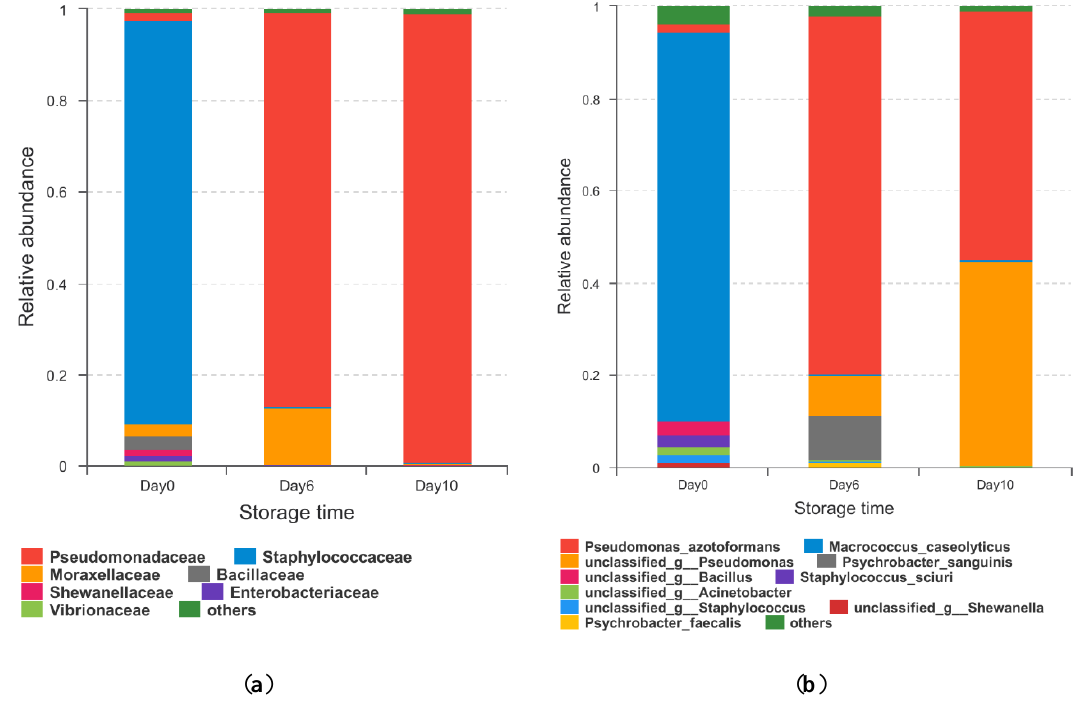
Figure 3. Community barplot analysis of microbiota at the genus level ( a ) and species level ( b ) from grouper fillets during storage.